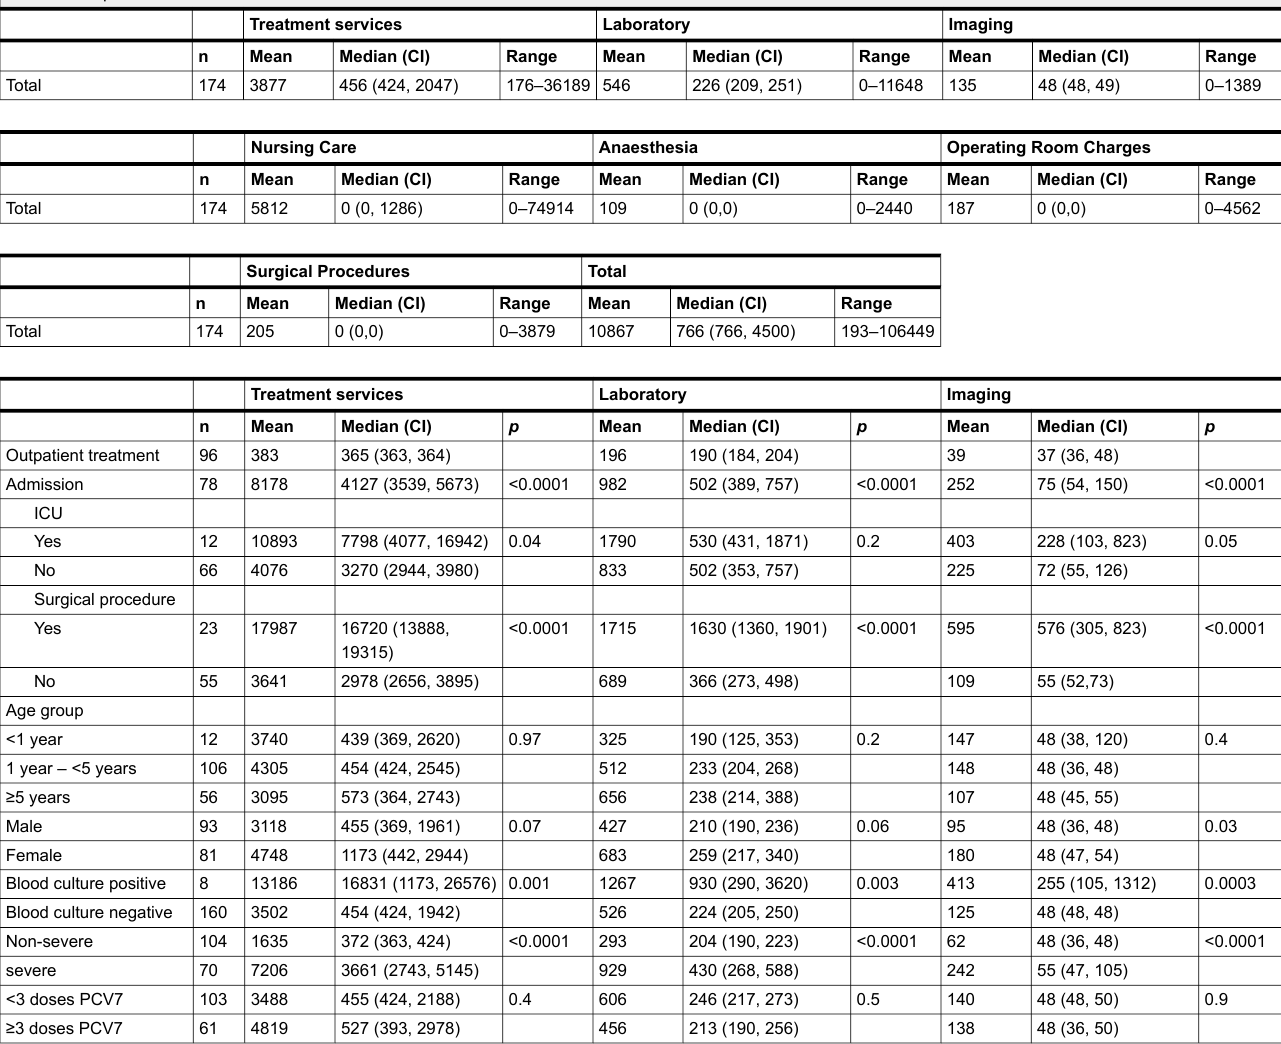
Table 2: Hospital costs associated with